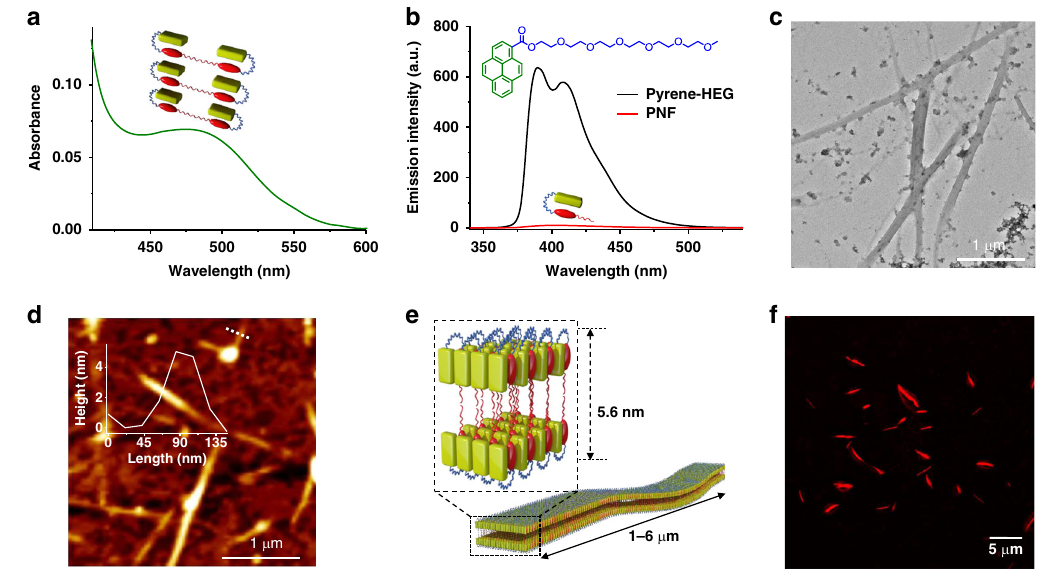
Fig. 2 Characterization of the native folded conformation of PNF and its self-assembly. a CT absorption band of PNF, originating from the intramolecular folded conformation and b corresponding quenched emission of pyrene due to CT interaction, compared with the emission of the model molecule, Pyrene- HEG, ( λ exc = 300 nm). Inset shows the molecular structure of Pyrene-HEG. c TEM and d AFM images of the tape structures along with the height pro fi le shown in inset. e Schematic for the bilayer packing of the folded PNF molecules in the tape structure. f Structured illumination microscopy (SIM) image of the tape structures loaded with Nile red dye in the bilayer ( λ exc = 561 nm). [PNF] = 5 × 10 − 5 M, [Pyrene-HEG] = 5 × 10 − 5 M, [Nile red] = 5 µ M. CH 3 CN/ H 2 O (1:1 v/v), pH = 8,